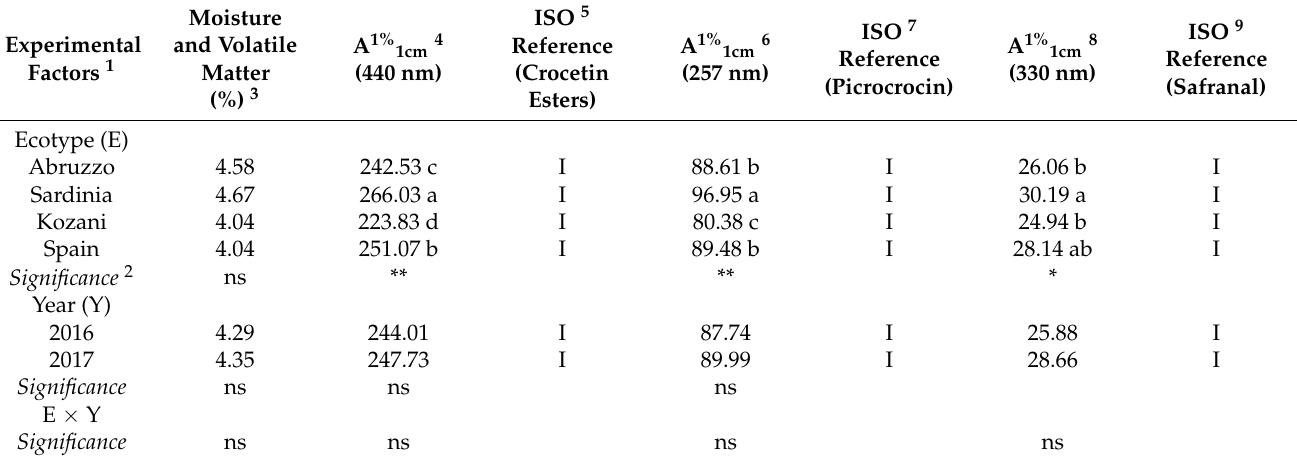
Table 6. Moisture and volatile matter, coloring, bittering, and aromatic powers related to ecotype (E), year (Y), and their